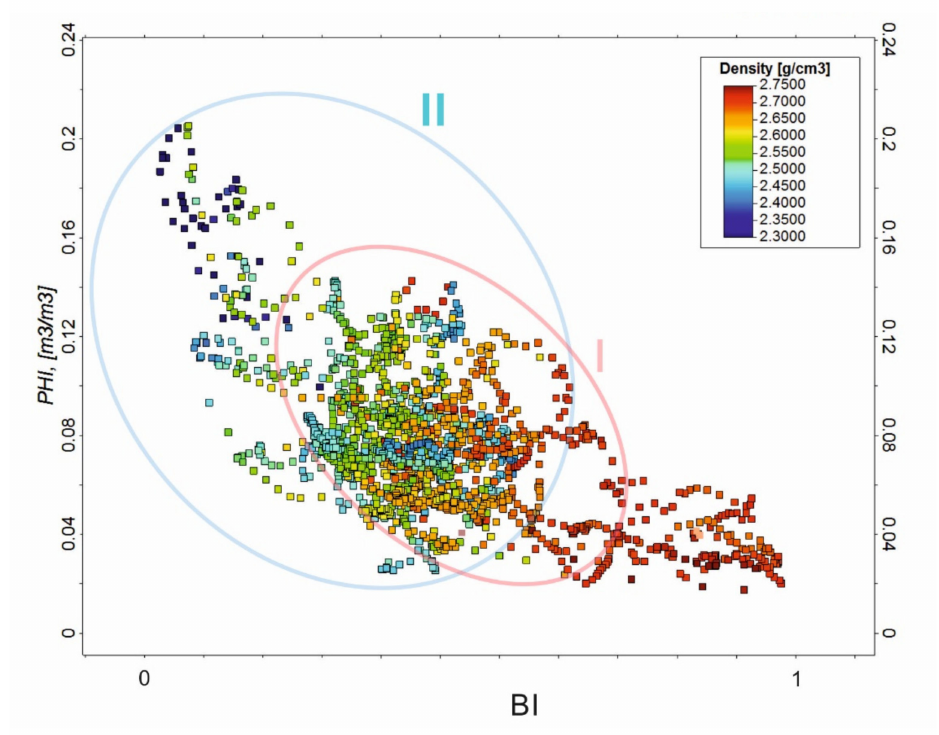
Figure 10. BI elast vs. porosity (PHI; ϕ ) as a function of density within Source I (red circle) and Source II (blue